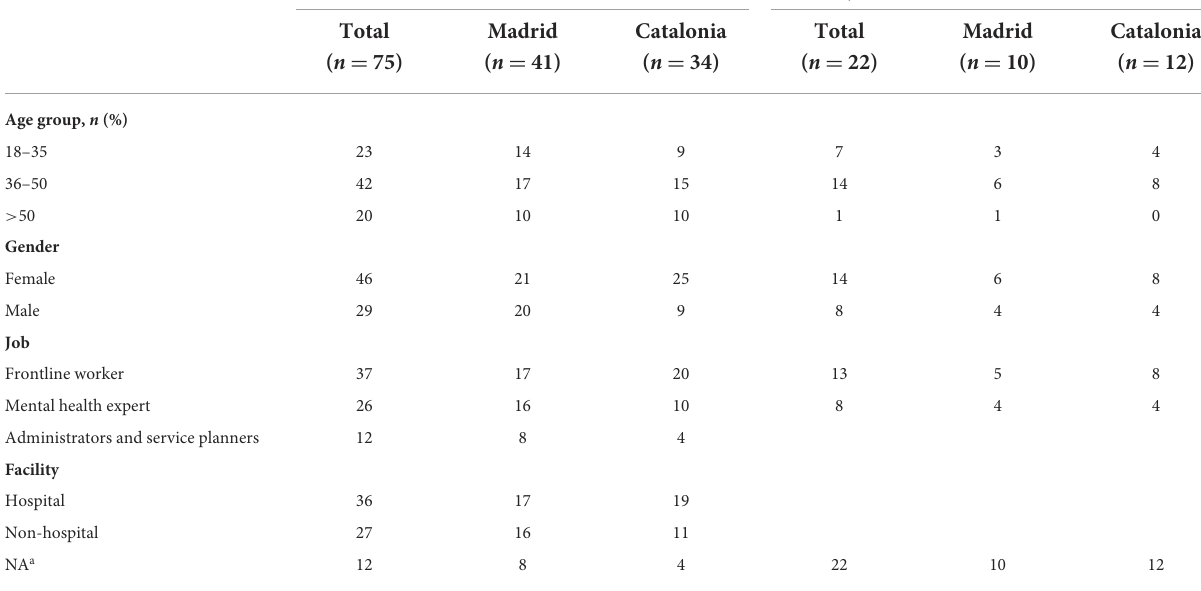
TABLE 2 Characteristics of the